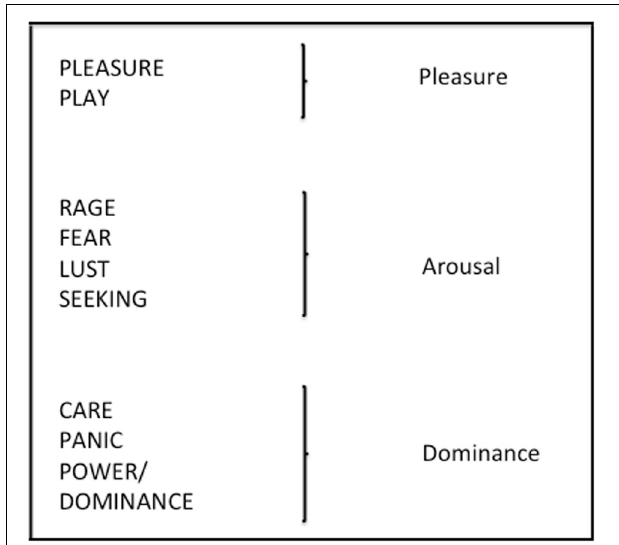
FIGURE 7 | Panksepp’s (1998) seven core emotional systems, augmented by Pleasure and Power Dominance (after Toronchuk and Ellis, 2010) and related to Mehrabian and Russell’s (1974) tripartite classification of